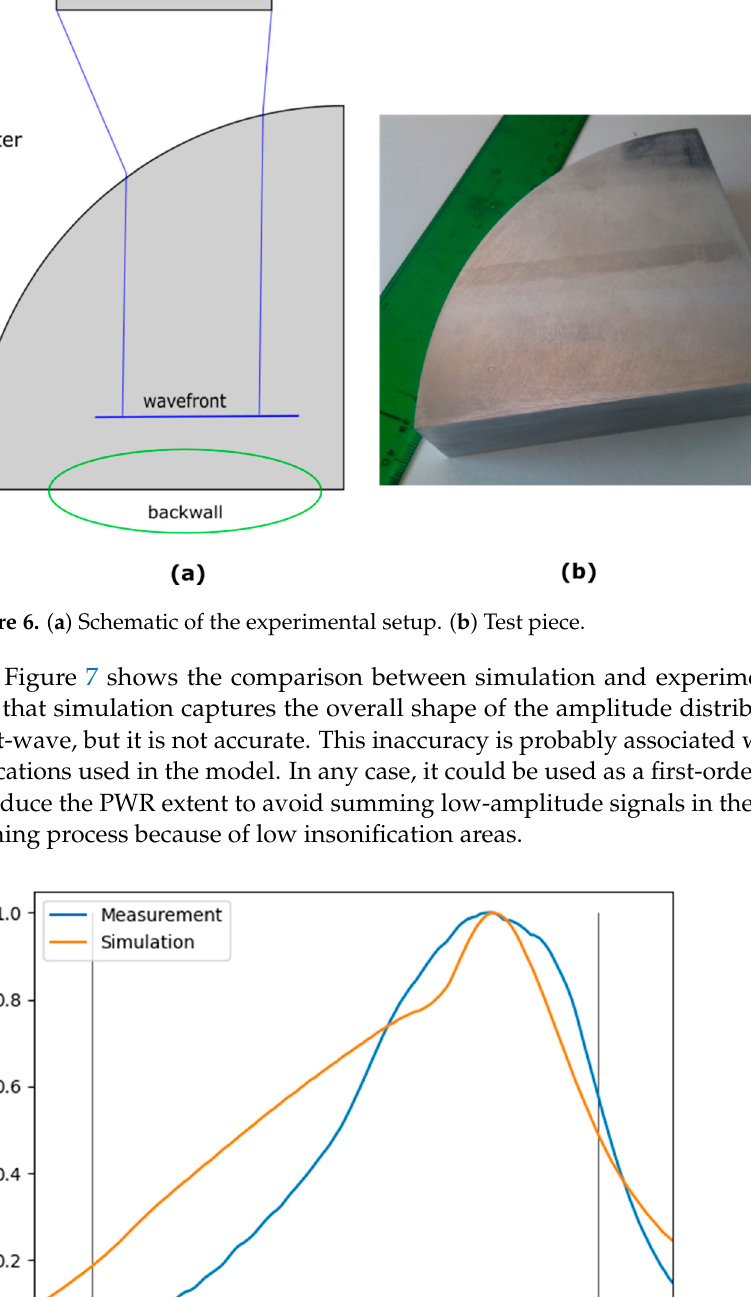
Figure 7. Simulated amplitude on wavefront compared to backwall echoes for each array element.